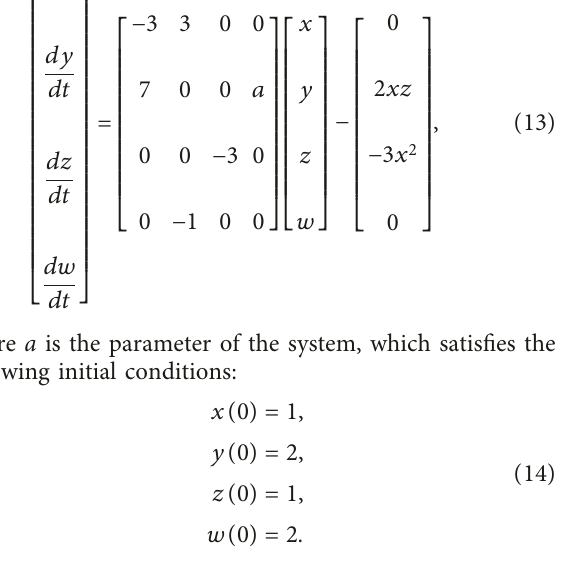
Figure 1. The complex dynamic behaviors of Experiment 3 are shown in Figures